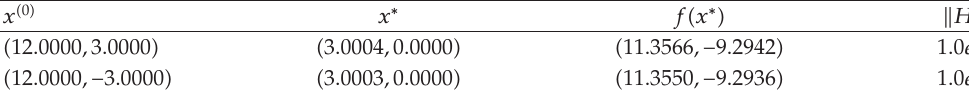
Table 2: Results for Example